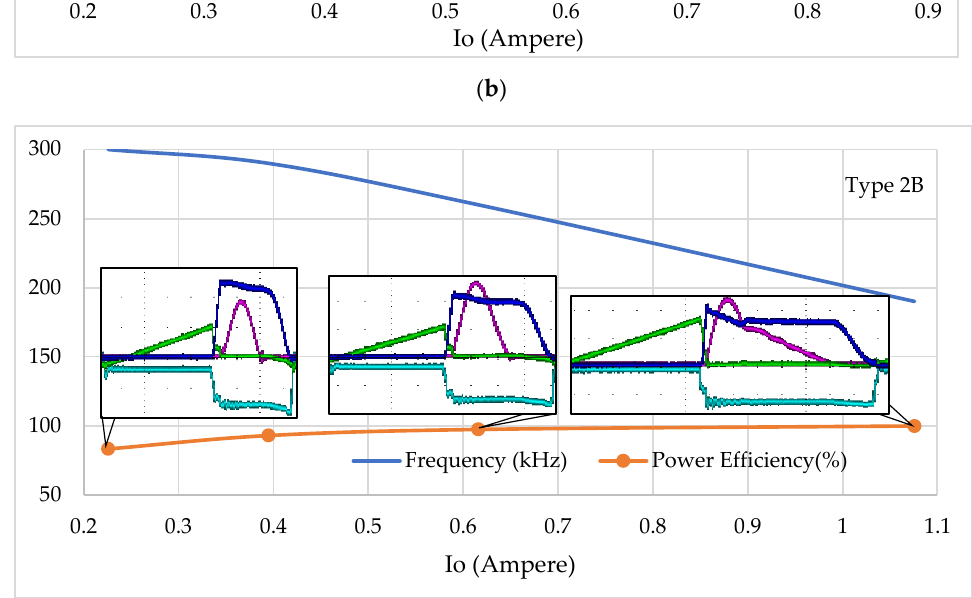
( a ) ( b ) Figure 14. DCM response comparison under the same switching frequency and duty. ( a ) power efficiency vs. V DD ; ( b ) output power vs. V DD .